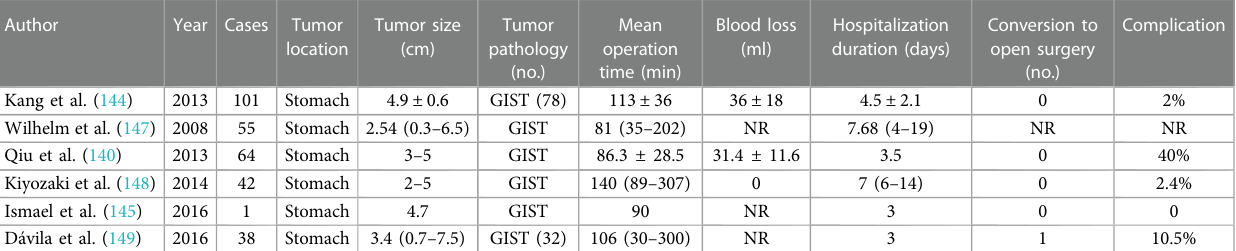
TABLE 8 Research studies of the EAWR